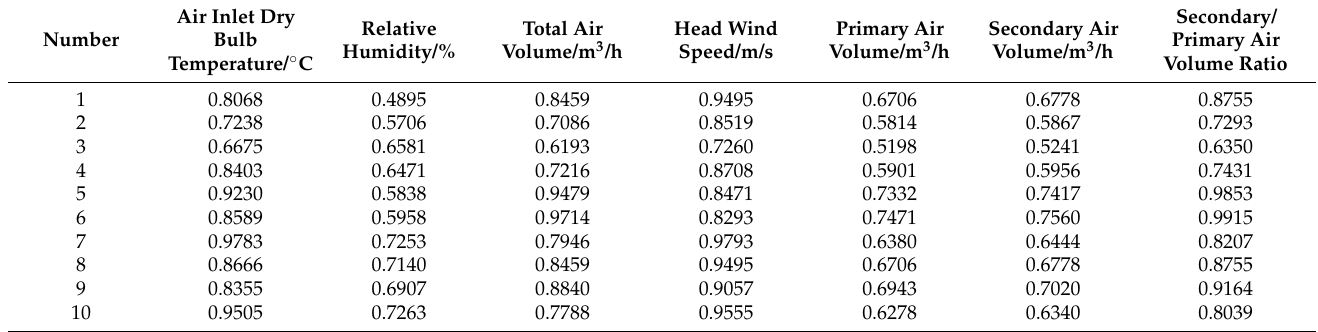
Table 3. Partial calculation results of the correlation coefficients of seven input variables.